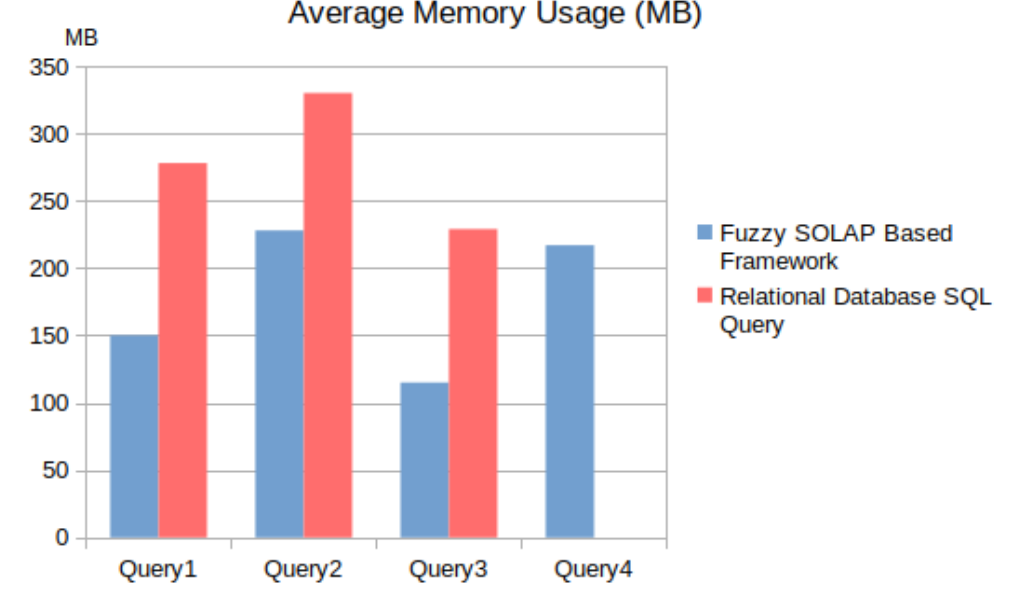
Figure 22. Average memory usage of FSOLAP and relational database SQL queries.